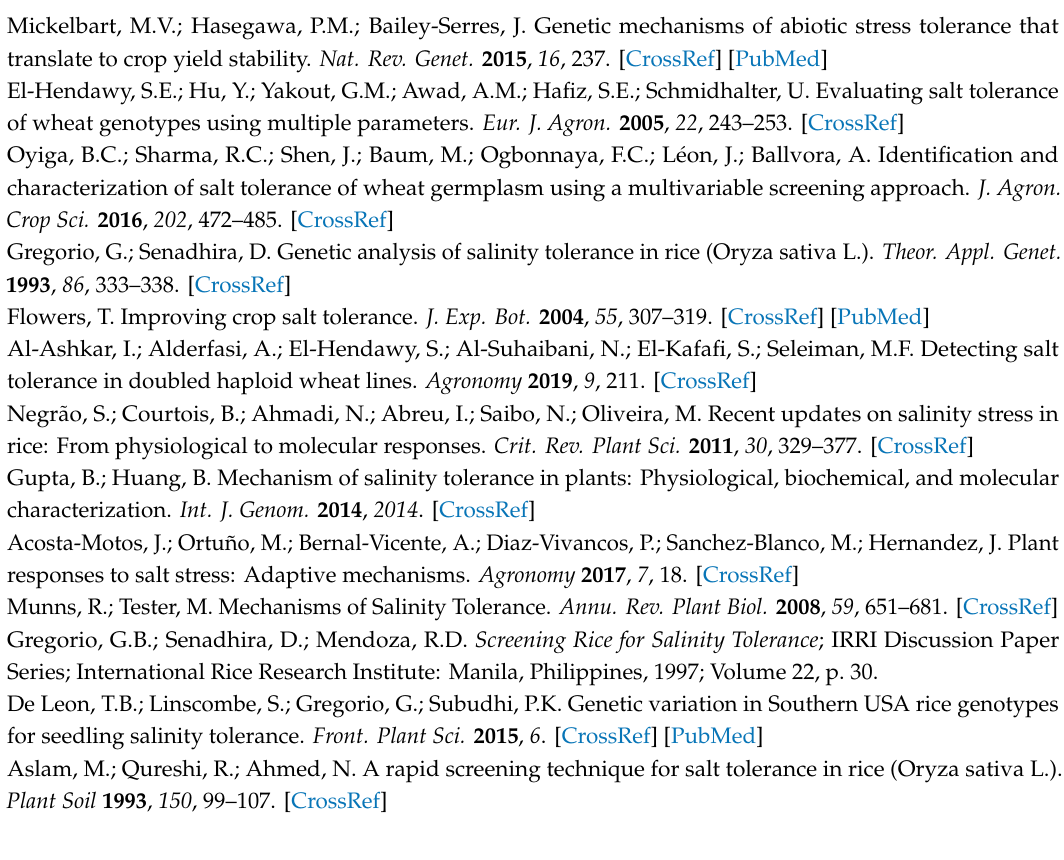
Figure S1. Mean performance of chlorophyll content (ChL) and membrane stability index (MSI) for eighteen wheat genotypes grown under control and salinity conditions. Table S1. The pedigree and salt tolerance of the three checked bread wheat cultivars used in this study. Table S2. List of SSR markers used in the study across 18 wheat genotypes. Table S3. Analysis of the di ff erences between the groups of relative turgidity shoot dry matter and traits. Table S4. Morphological distance (MD) estimation between 18 wheat genotypes based on the relative change of the RT and SDM. Table S5. Genetic distance (GD) estimation between 18 wheat genotypes using SSR molecular